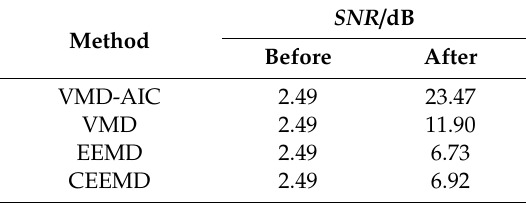
Table 1. The SNR before and after denoising the wavelet by different methods.